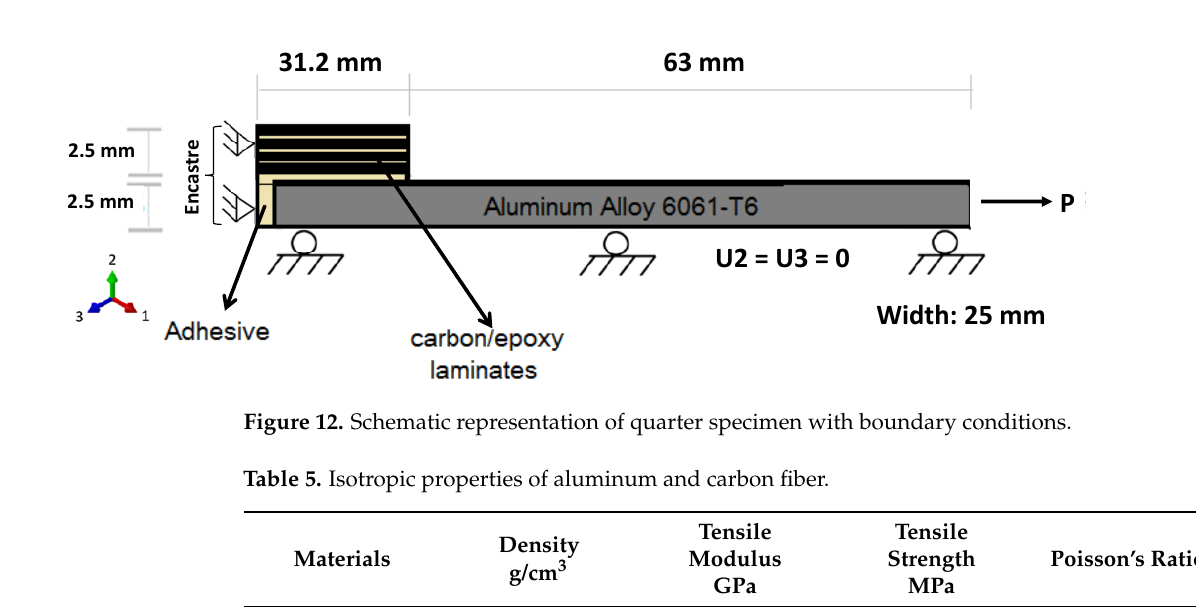
Table 6. Directional stiffness properties of adhesive.